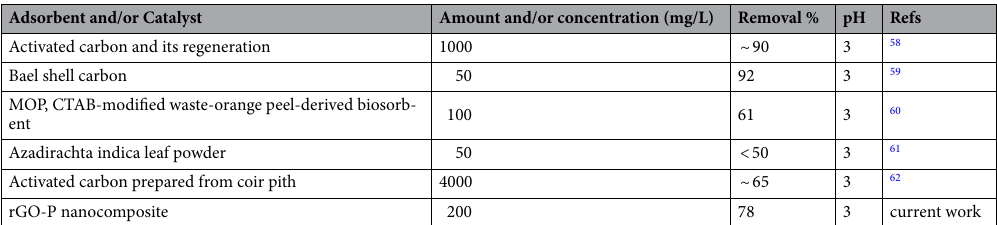
Adsorbent and/or Catalyst Amount and/or concentration (mg/L) Removal % pH